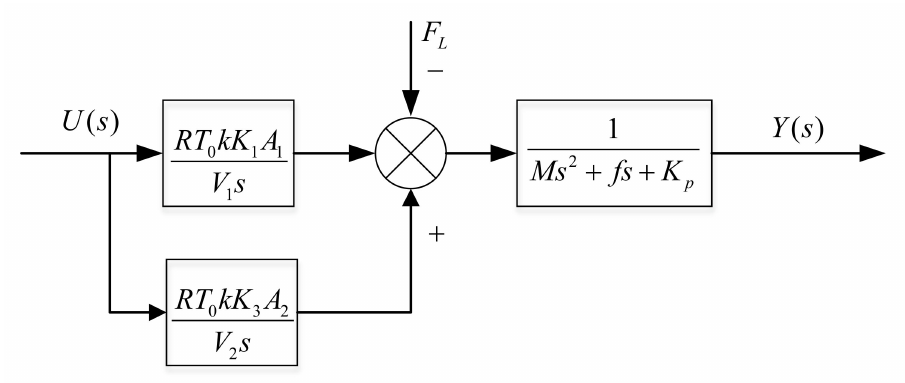
Figure 5. Block diagram of the open-loop transfer function of the pneumatic servo